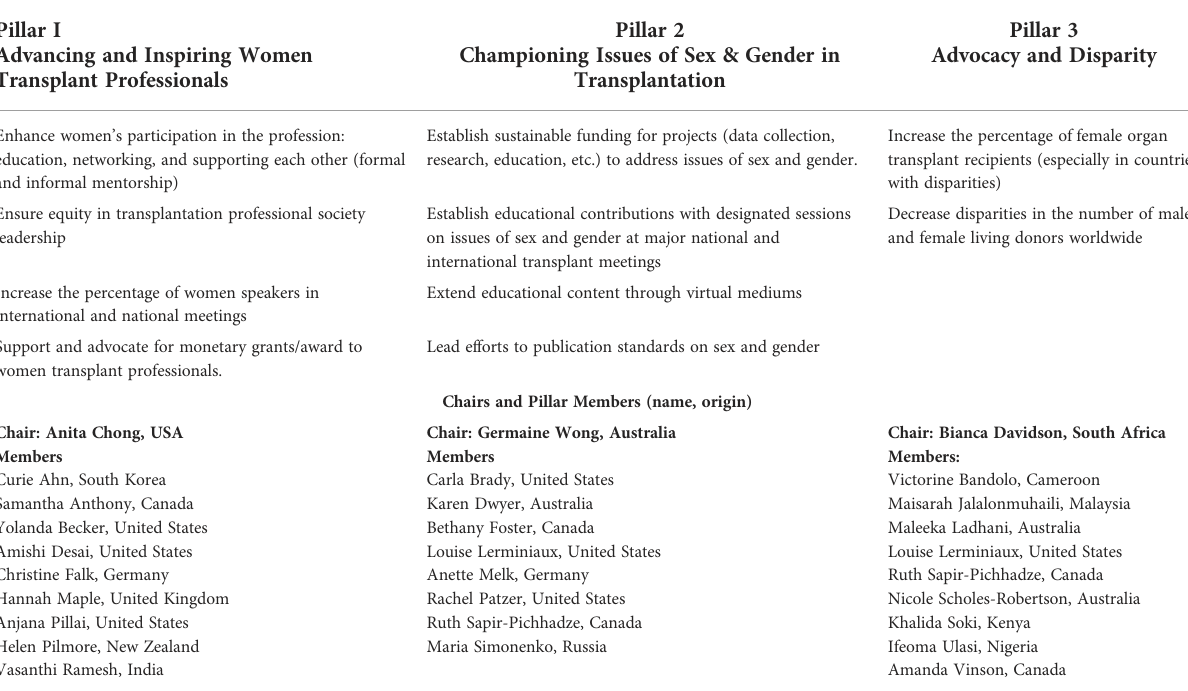
TABLE 1 Pillars and goals of women in